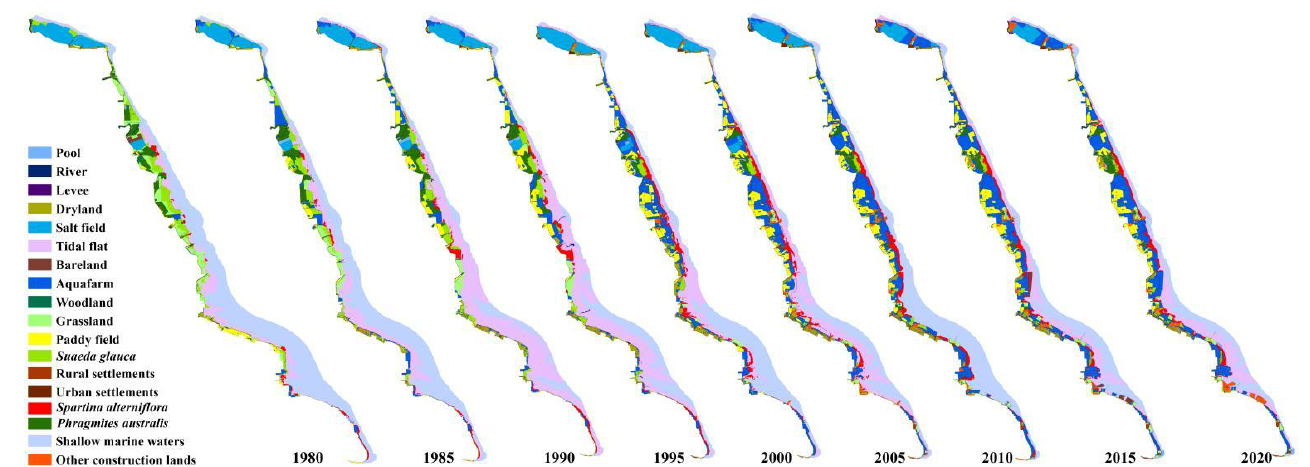
Figure 2. Landscape map of the coastal wetlands in Jiangsu, China, 1980–2020.